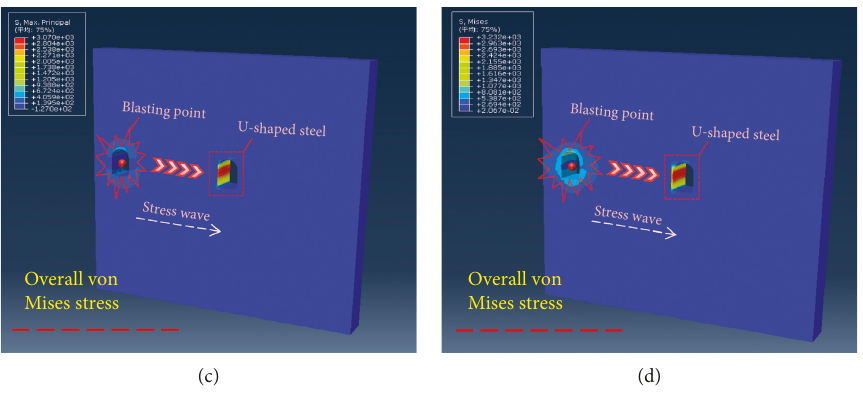
Figure 16: The overall equivalent stress for blasting. The effect of blasting disturbance on U-shaped steel is obtained under the explosive charge of 32 kg (a), 40 kg (b), 48 kg (c), and 60 kg (d). Explosives act on U-shaped steel in the form of explosive waves through rock mass. The maximum equivalent stress is 7.6812 Pa, 1.8073Pa, 3.073Pa, and 3.2323Pa, respectively. Therefore, the damage caused by the explosive wave of 60kg explosive amount to the U-shaped steel also does not reach the yield strength.